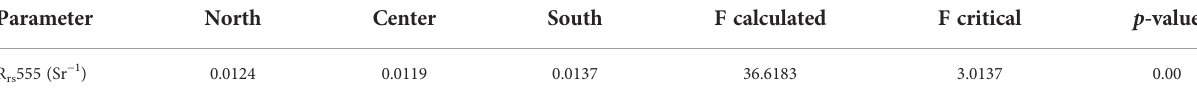
TABLE 2 Monthly mean values of R rs 555 for each region of the Sofala Bank and resulting variance analysis for a critical value of 0.001. Parameter